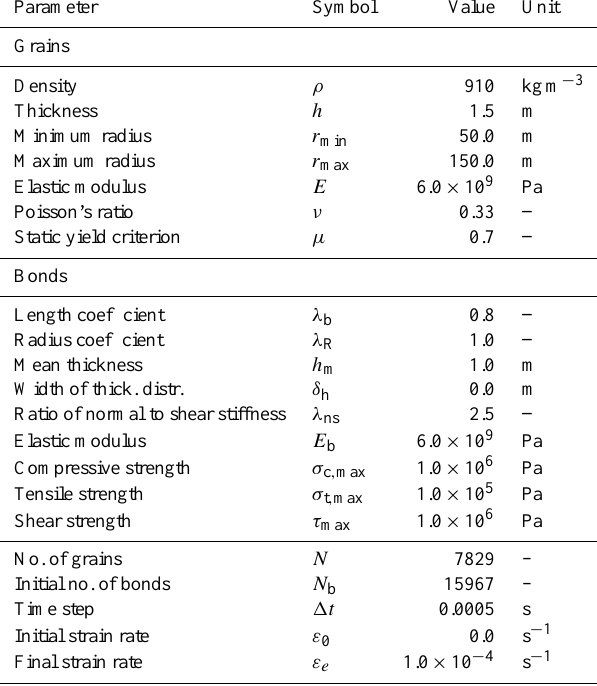
Table 1. Physical and numerical model parameters used in the ref- erence simulations in Sect.